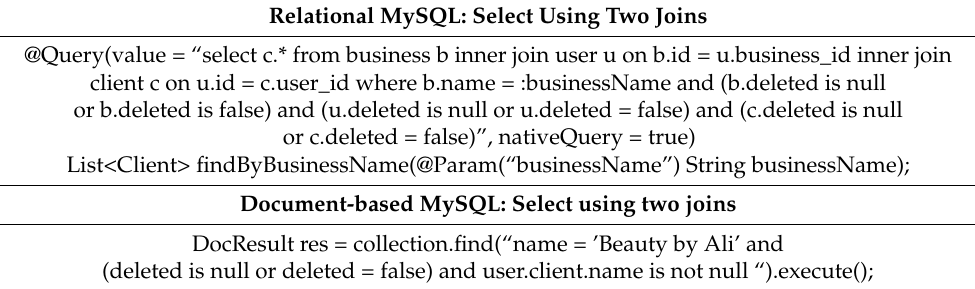
Table 10. Select operation using two